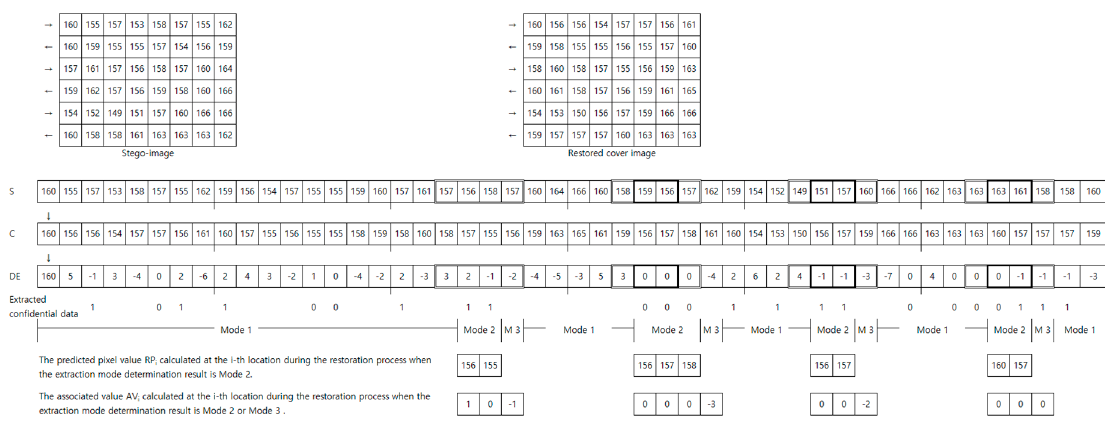
Figure 12. Data extraction and original cover image restoration using the ARDHA technique algorithm.